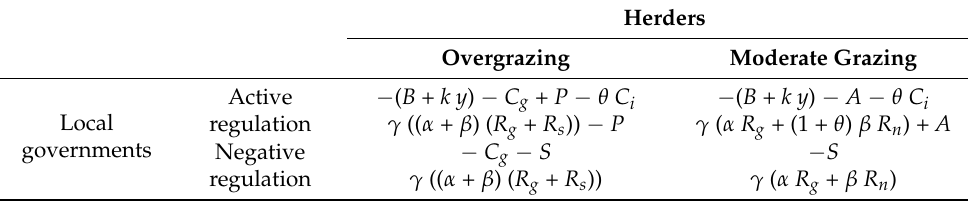
Table 2. Payment matrix for the evolutionary game.